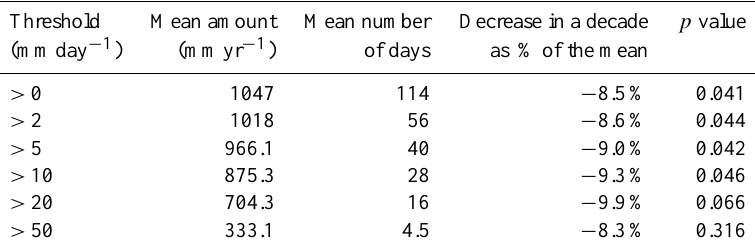
Table 4. Analysis of precipitation trends for different intensity thresholds for the period from 1966 to 2006 for the Rimbaud watershed in